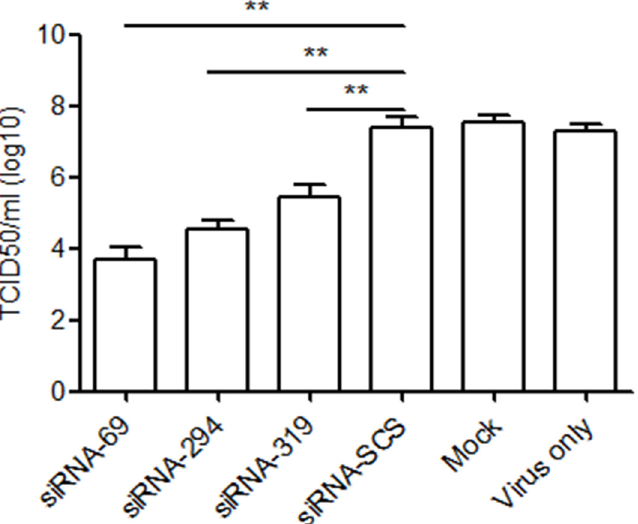
Fig 4. Viral titer assay. Virus titers were determined in term of TCID 50 . RD cells pretreated with siRNAs were infected with strain EV71-2006-52-9 at an MOI of 0.01. At 48 h postinfection, the supernatants were collected to detect the progeny viral titers. Data are the means ± SD of three independent experiments ( ** p <